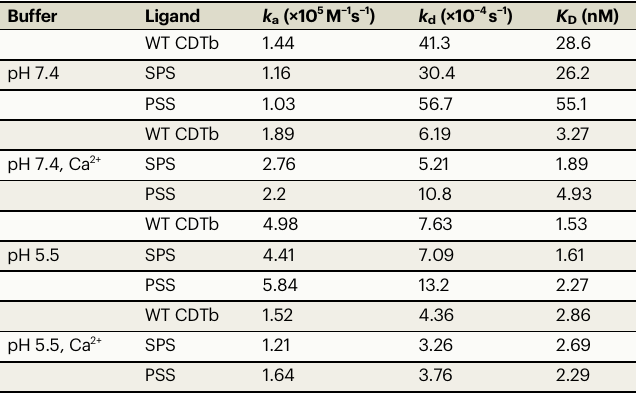
Table2 |Equilibriumbinding af fi nityand kinetic parameters of the interaction between CDTa and